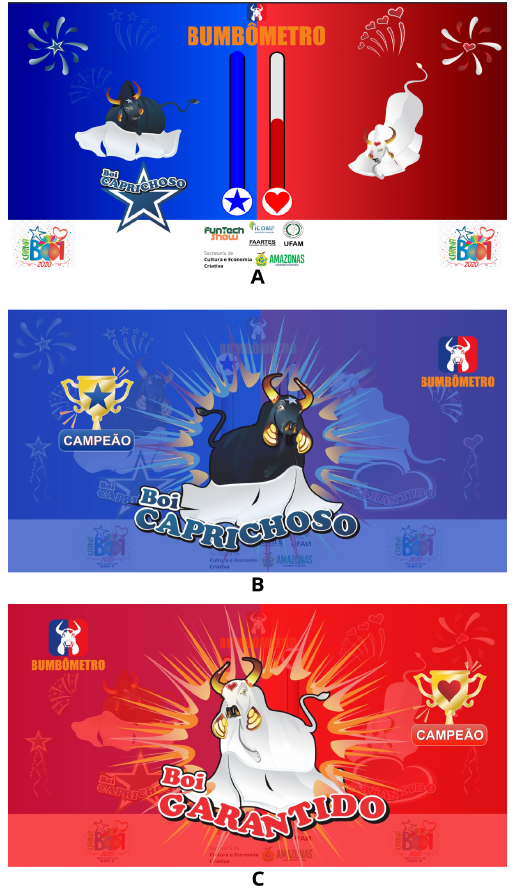
Figure 3. Web server module screens, where (A) each team has a thermome­ ter that moves according to the data captured by the set of the mobile, and (B) and (C) the winner screen that appears at the end of each session of the game (a match), for Caprichoso and Garantido, respectively.